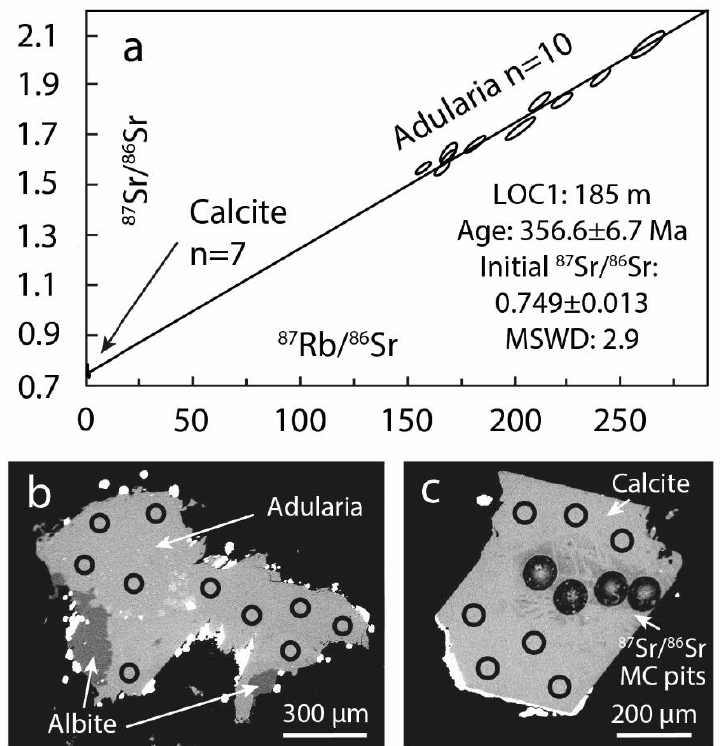
Figure 4. In situ Rb-Sr dating results of the 185m sample with ( a ) the isochron diagram and data, and ( b,c ) individual spots marked as black circles on BSE images of the analysed adularia and calcite mineral grains.